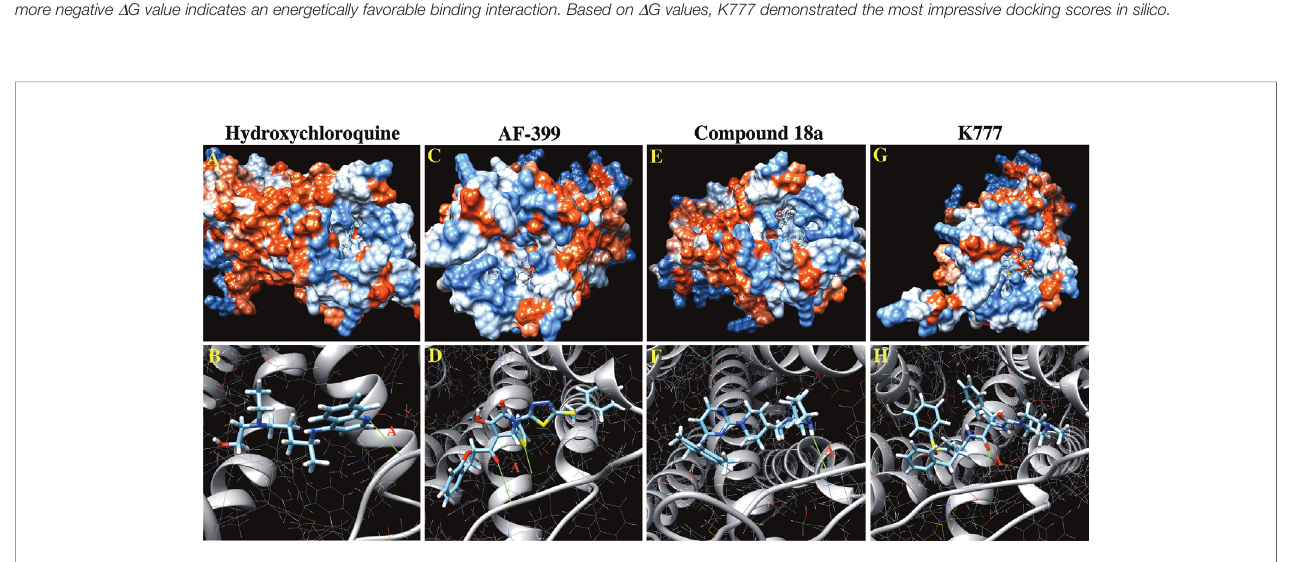
In vitro and in silico data for hydroxychloroquine and controls. The CCR4 IC50 value of hydroxychloroquine and K777 is unknown, whereas AF-399 and compound 18a demonstrate exceptional IC50 in the low nanomolar range. The FullFitness score summarizes the total number of ligand-to-protein interactions. A more favorable binding mode is indicated by a more negative FullFitness score. Cluster 0/Element 0 indicates the docking score that corresponds to the peak FullFitness score for each respective compound. All compounds demonstrate similar FullFitness scores in cluster 0/element 0, whereas controls compound 18a and K777 demonstrated exceptional Gibb ’ s Free Energy ( D G) values. Similar to the FullFitness score, a